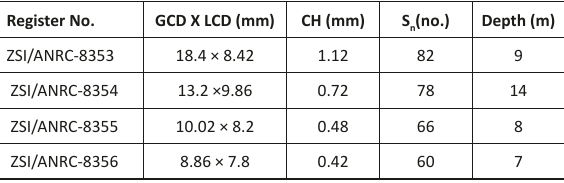
GCD - Greater Corallite Diameter; LCD - Lesser Corallite Diameter; CH - Corallite Height;